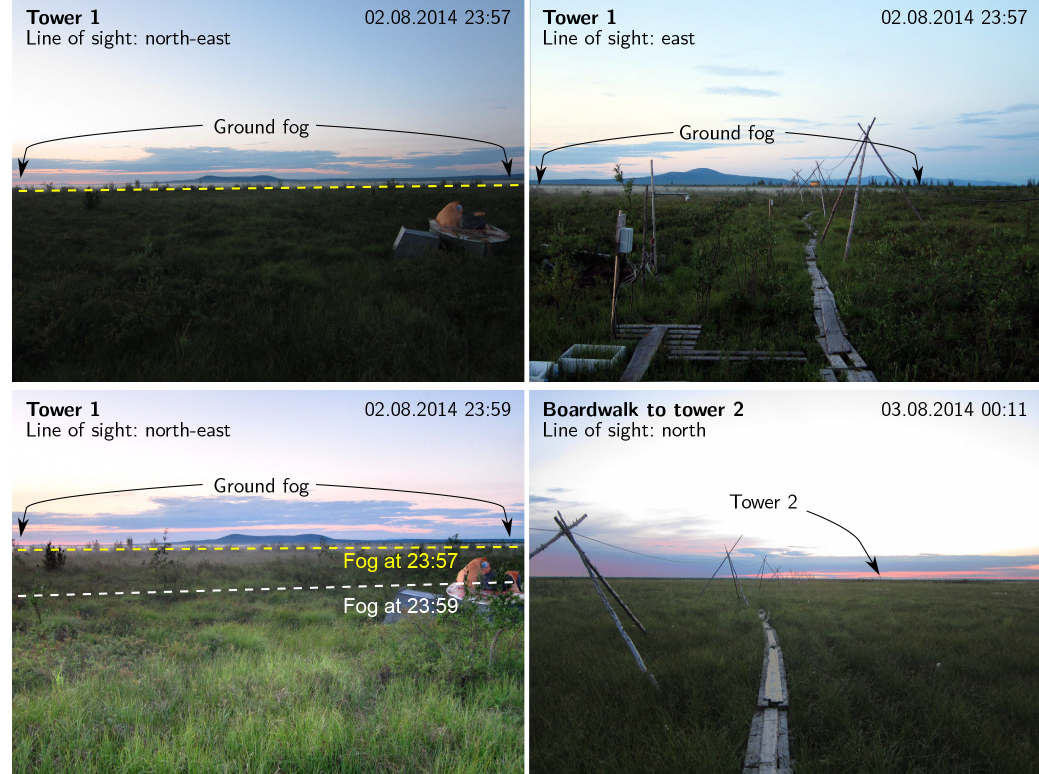
Figure 6. Photos of the study site directly at tower 1 (top and bottom left) and on the boardwalk between the power station at Ambolyka river and tower 2, taken between 2 August 2014 at 23:57MAGT and 3 August 2014 at 00:11MAGT. Table 2. Night-time frequency (21:00–09:00MAGT) of the wind directions over the whole measuring period for both towers in percent. The last row gives the frequency of wind directions observed for night-time peak events. Percentages greater than 20% are denoted in italics. Wind sector N NE E SE S SW W